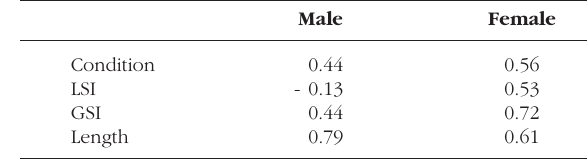
* all p-values were equal to 0.001. Table III. - Spearman correlation coefficient* of E. gadi abundance and condition factor, LSI, GSI and length of male and female M. scor- pius sampled from Peterhead Inlet and the Sylvia Grinnell River estuary, Nunavut.